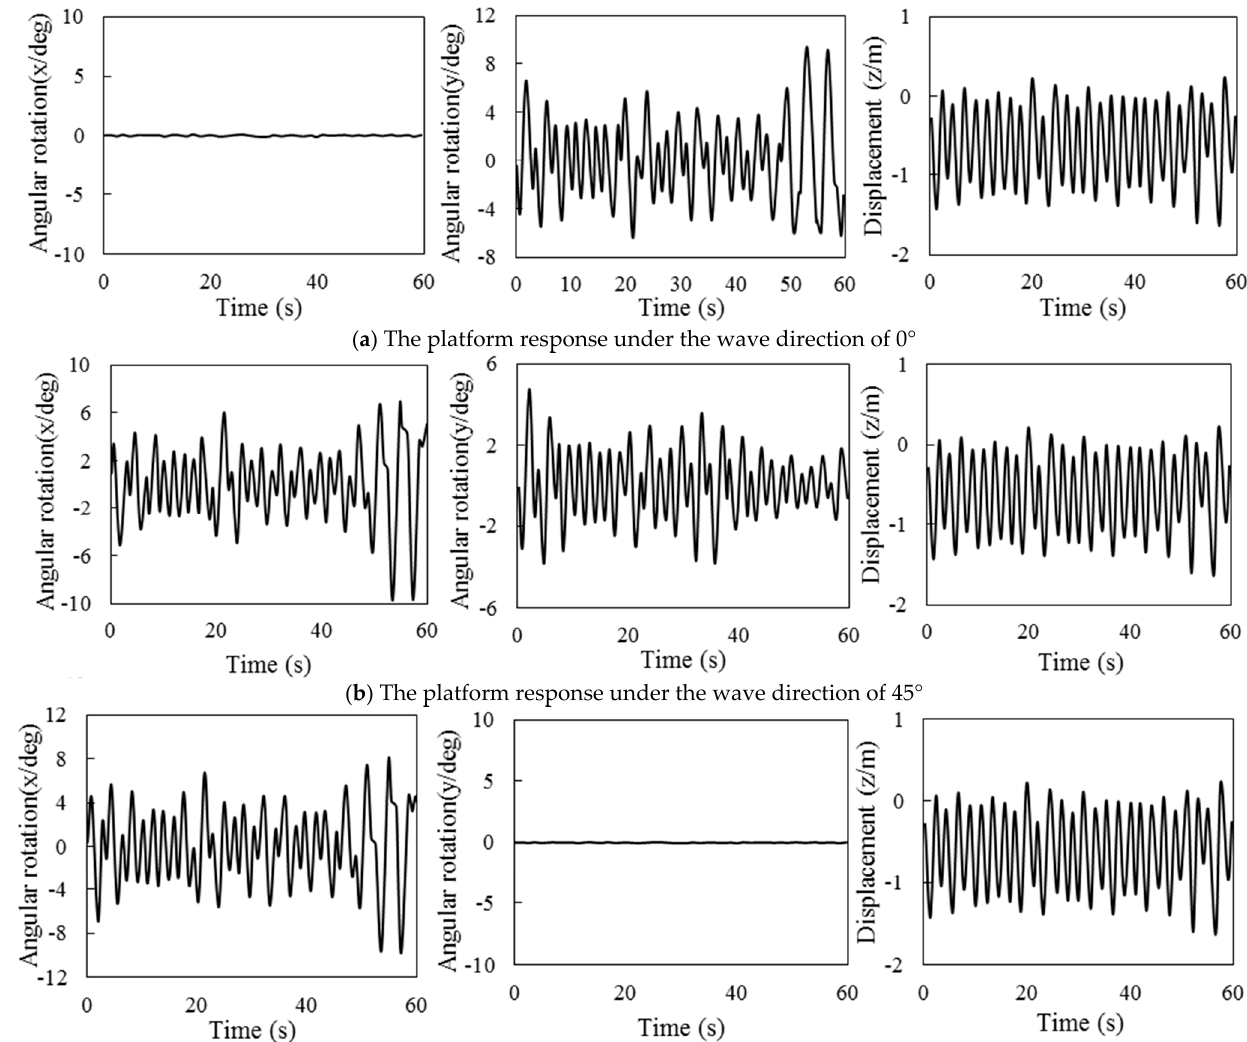
Figure 11. The platform response under wind − sea scale 3 with different wave directions.